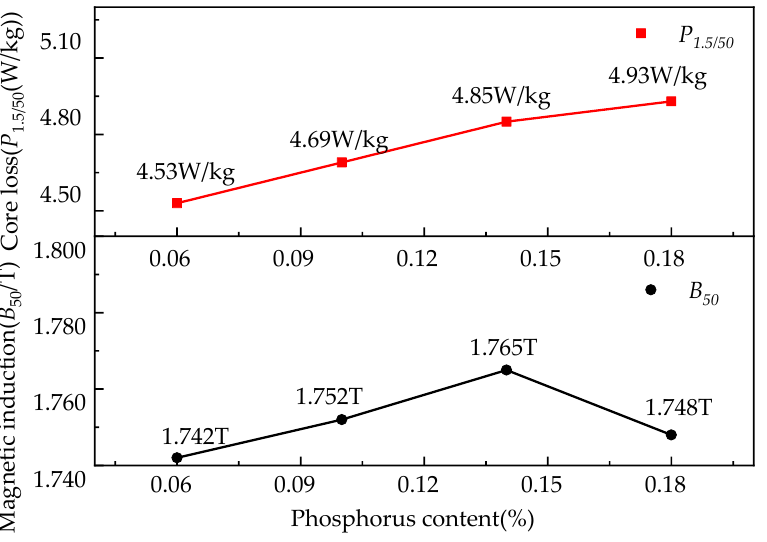
Figure 9. Effect of target P content on iron loss and magnetic induction.